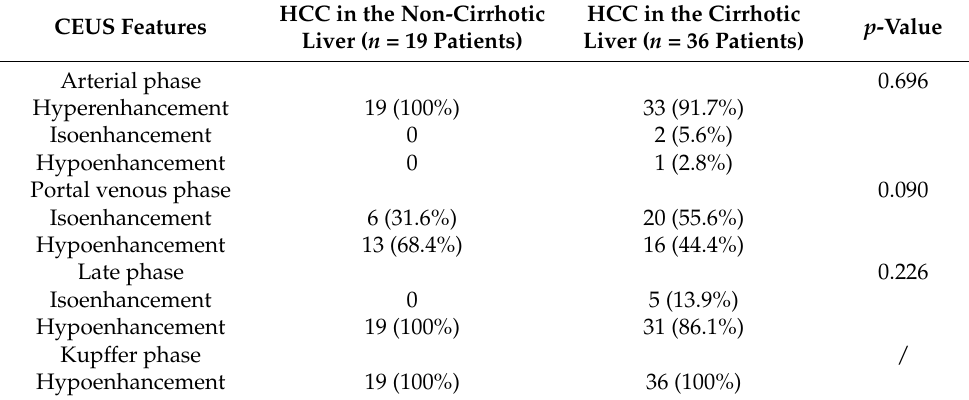
Table 3. CEUS features between two groups.